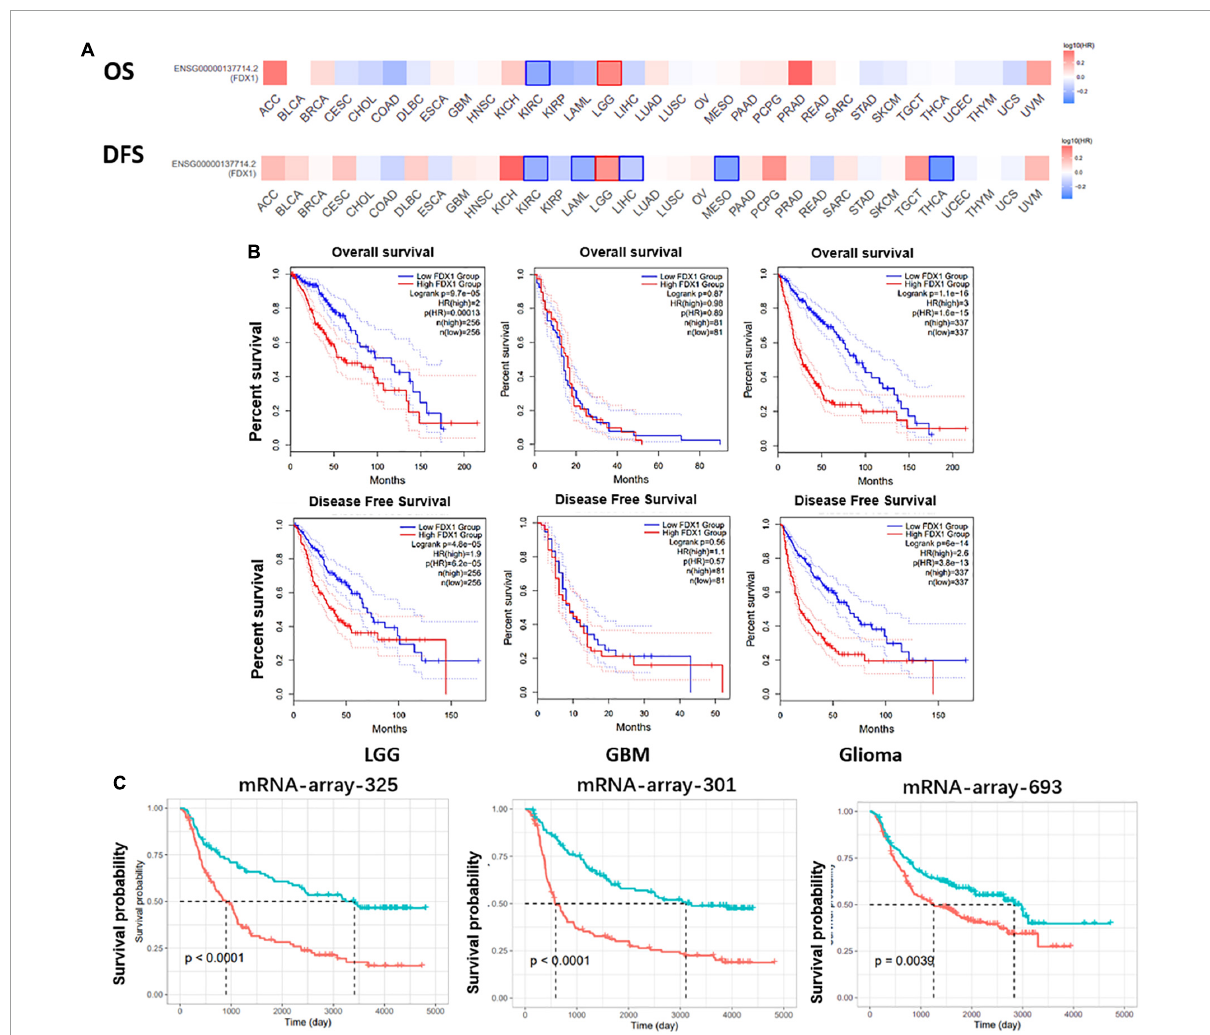
FIGURE4 Potential prognostic value of FDX1 in glioma. (A) The overall survival and progression-free survival curve of FDX1 in glioma. (B) Survival analysis of glioma in TCGA database. (C) Survival analysis of glioma in CGGA